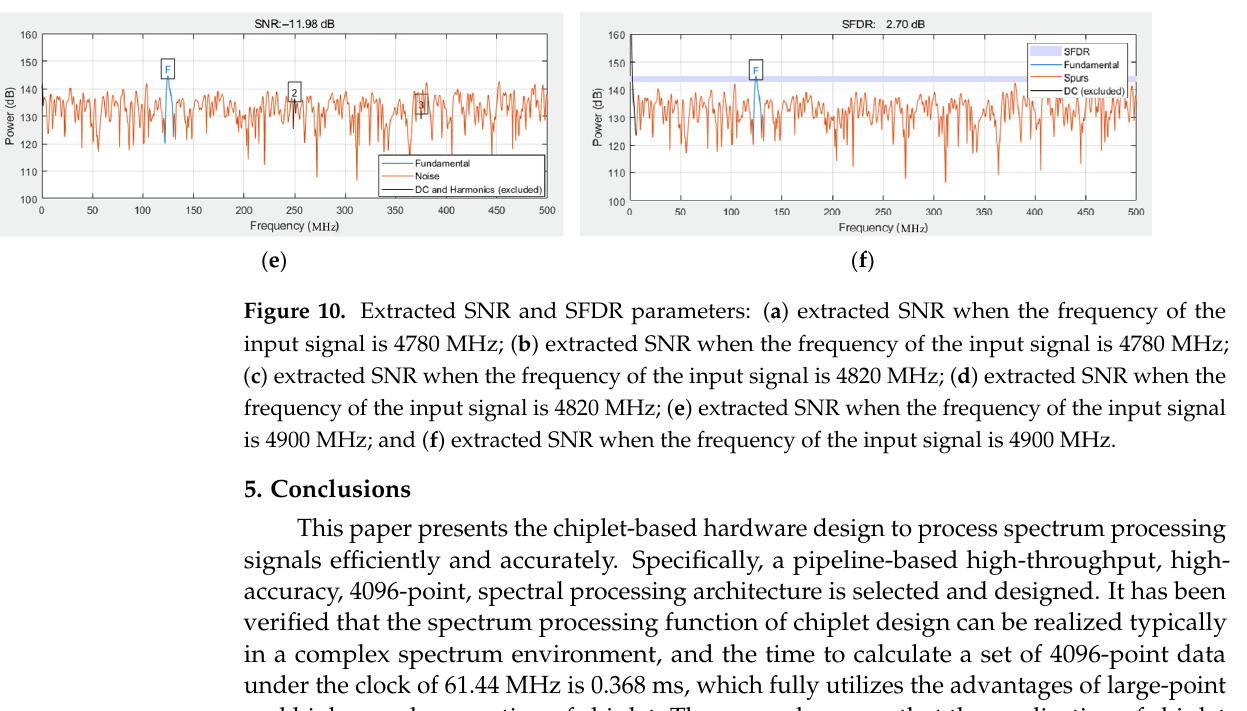
11 of 13 Table 2. Comparison of simulation results. Parameter